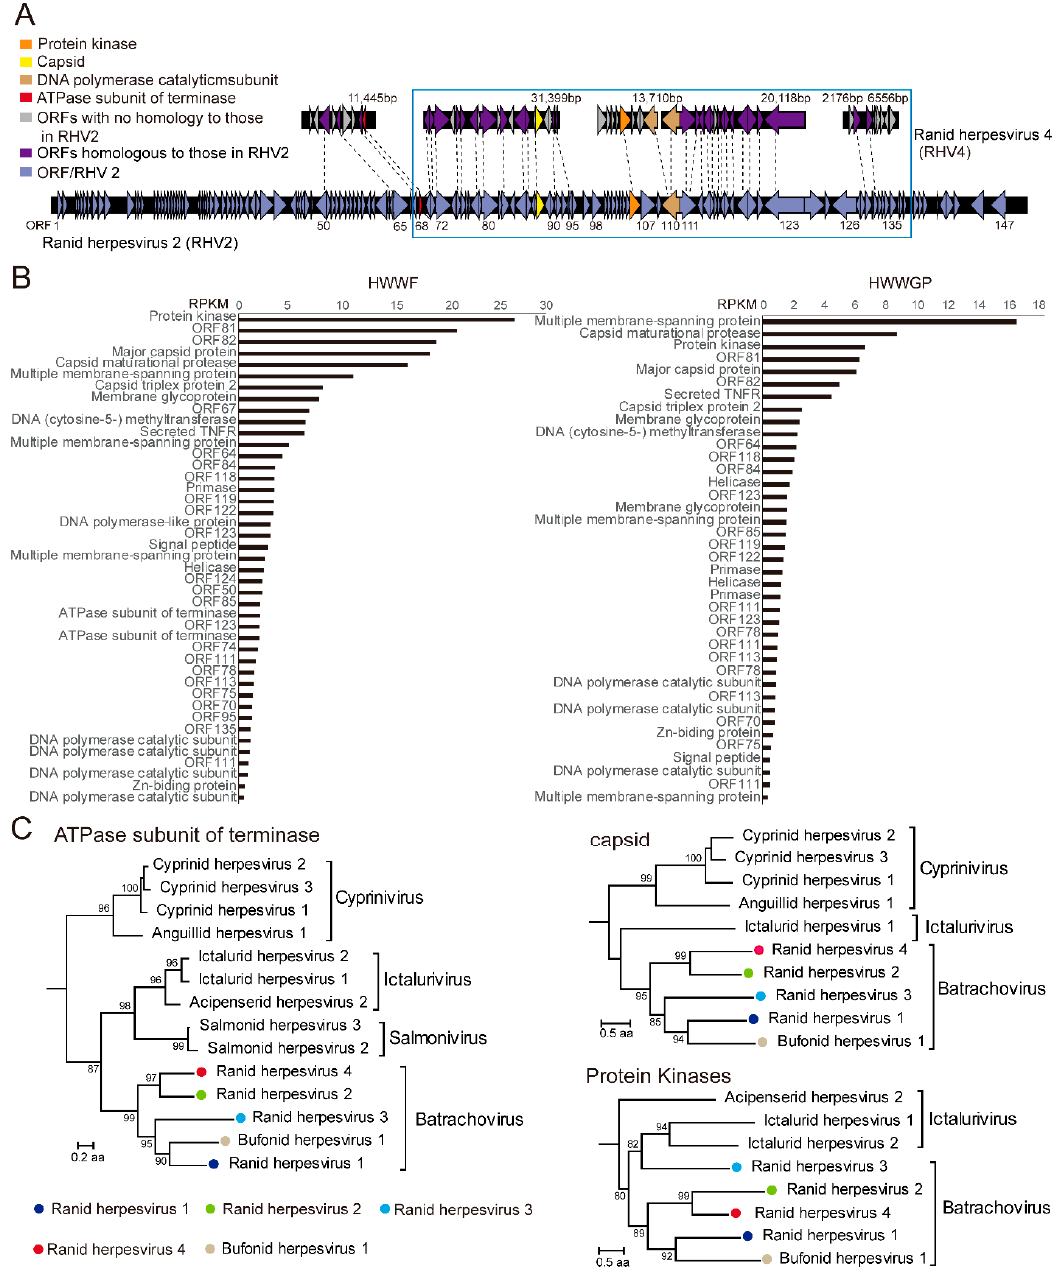
Figure 2. Genomic, transcriptomics, and phylogenetic analyses of the newly identified ranid herpesvirus 4. ( A ) Comparison of the genome structures of ranid herpesvirus 2 (RHV2, NC_008210.1) and RHV4. Genes are shown as rectangles with arrow tips showing the transcription direction, and those conserved in both viruses are connected with dotted lines. ( B ) Bar graph showing the expression levels of different genes by RHV4 in lung (HWWF) and liver/spleen (HWWGP) tissues. The horizontal axis represents the abundance of each gene as measured by RPKM. ( C ) The maximum likelihood phylogenetic trees based on the capsid maturational protease (capsid), ATPase subunit of terminase, and protein kinase proteins, respectively, showing the positions of RHV4 (solid red circle) within the diversity of the family Alloherpesviridae . Four amphibian-associated herpesviruses discovered previously are marked in different colors. All trees are midpoint rooted, and the taxonomy information is labelled to the right of each